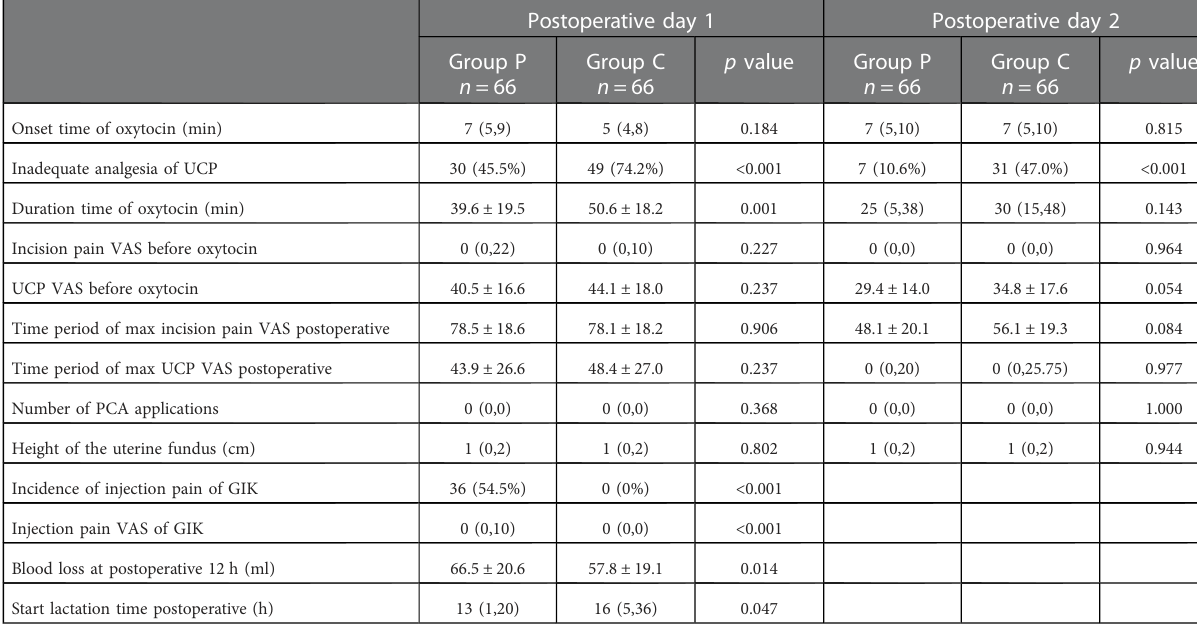
TABLE 3 Secondary outcomes on postoperative days 1 and 2.